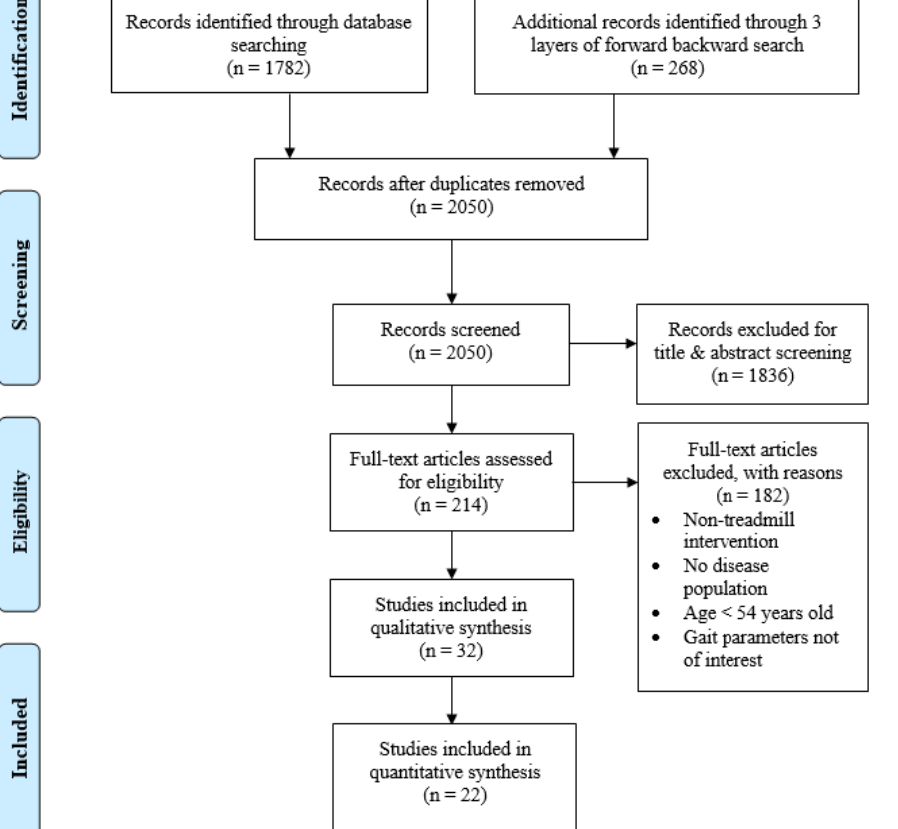
Figure 1. Study selection flow